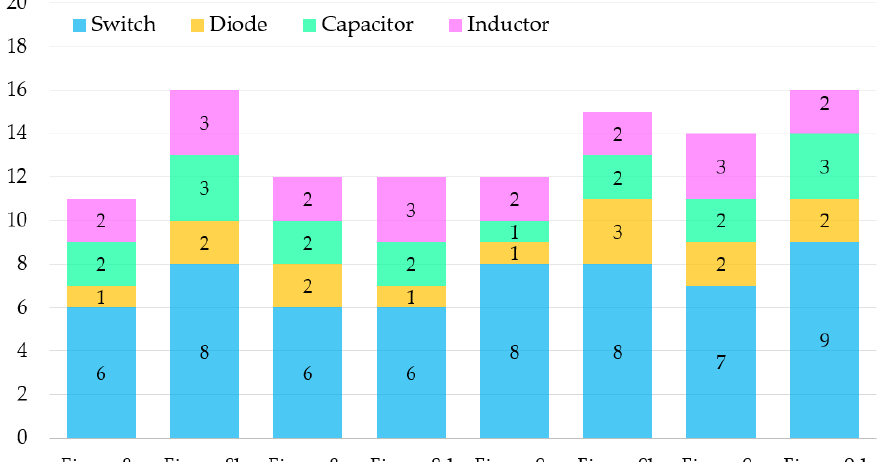
Figure 10. The components for topologies enlisted in Table 3.